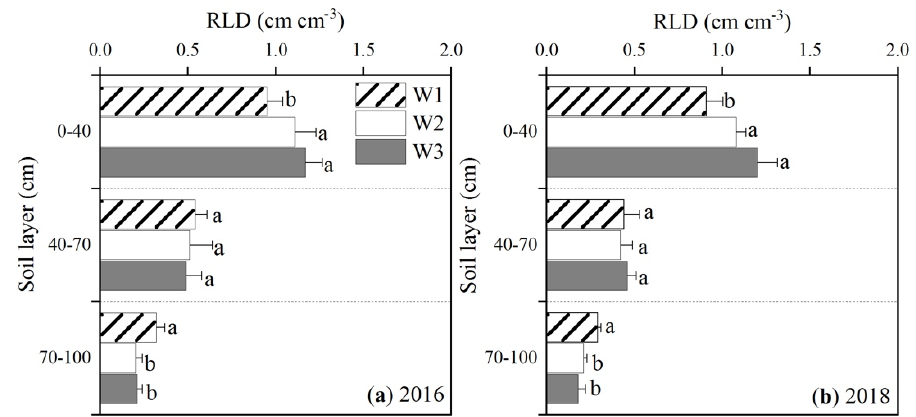
Figure 3. Root length density (RLD) for 0–40 cm, 40–70 cm and 70–100 cm soil layers ( a ) in 2016 and ( b ) in 2018. W1, W2 and W3 are the treatments with different D h (designed wetting depth). D h values in W1, W2 and W3 are 0–40 cm, 0–50 cm and 0–60 cm, respectively. Horizontal bars represent standard errors. Different letters above bar plot indicate that there are significant differences in RLD between means for a specified soil layer ( P < 0.05).